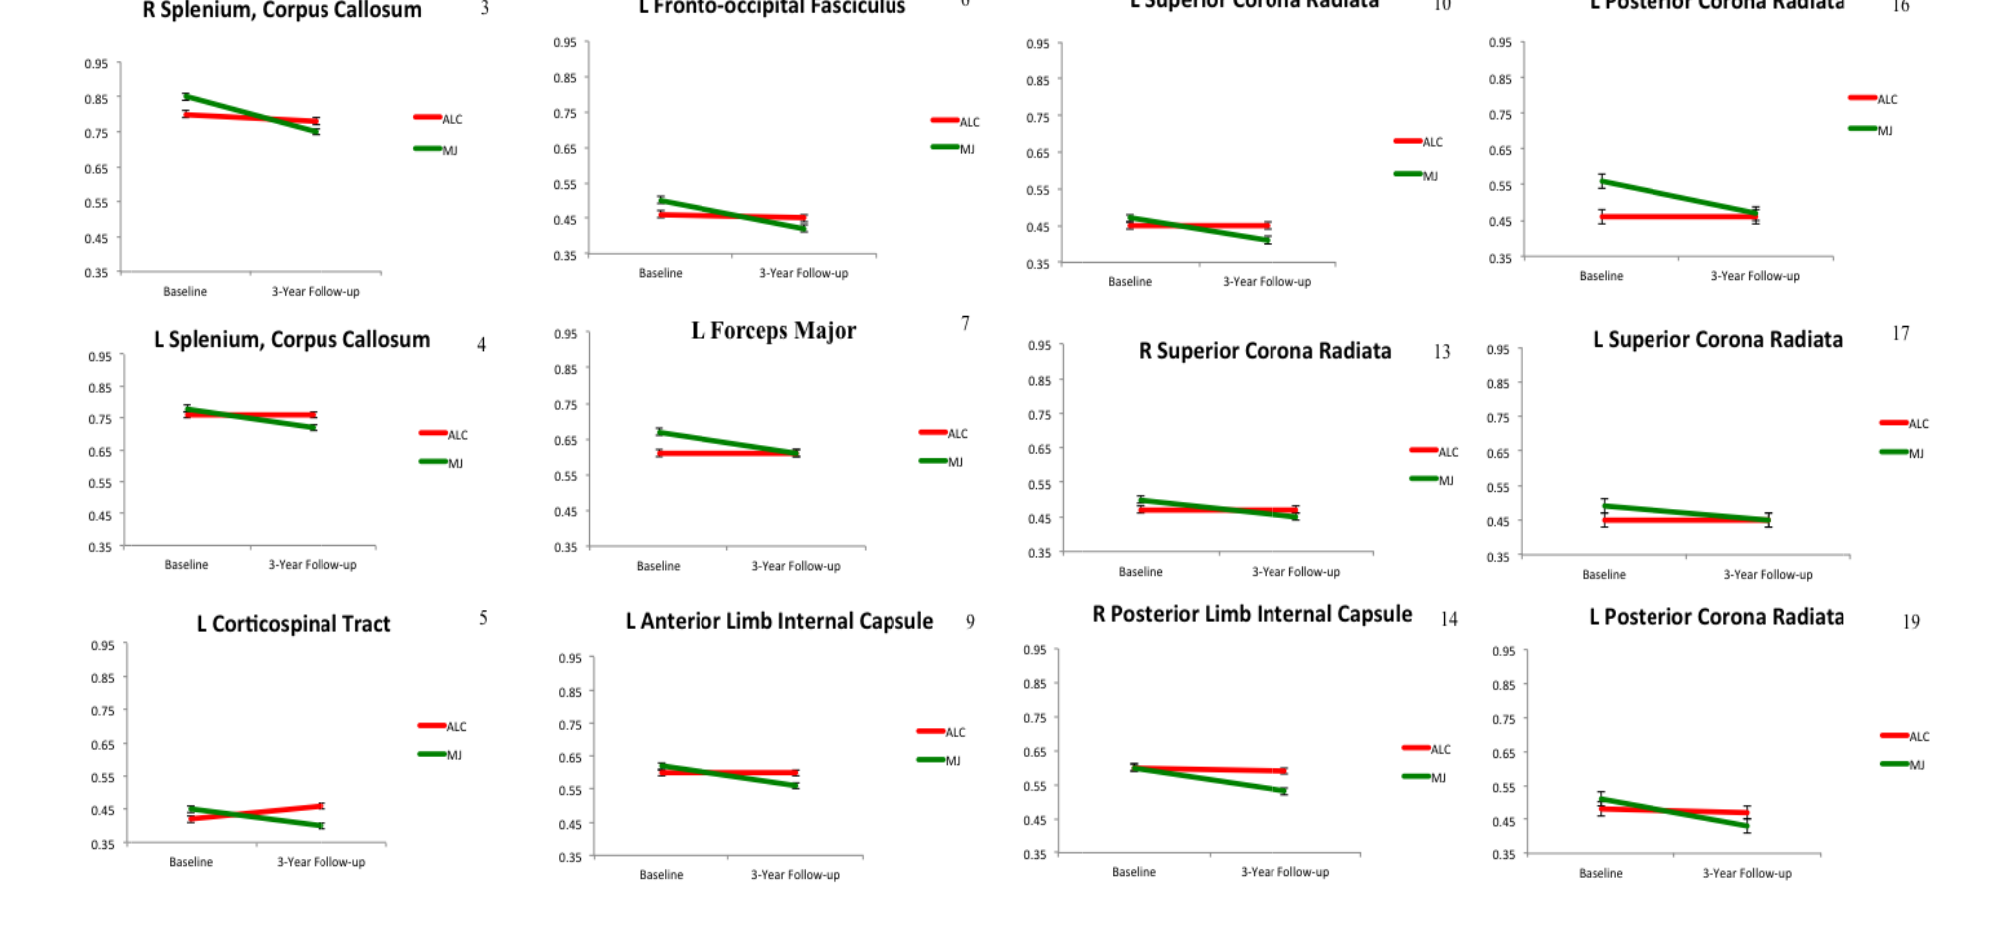
Figure 2. Grou correspup by time inter ractions for numbers ponds to cluster